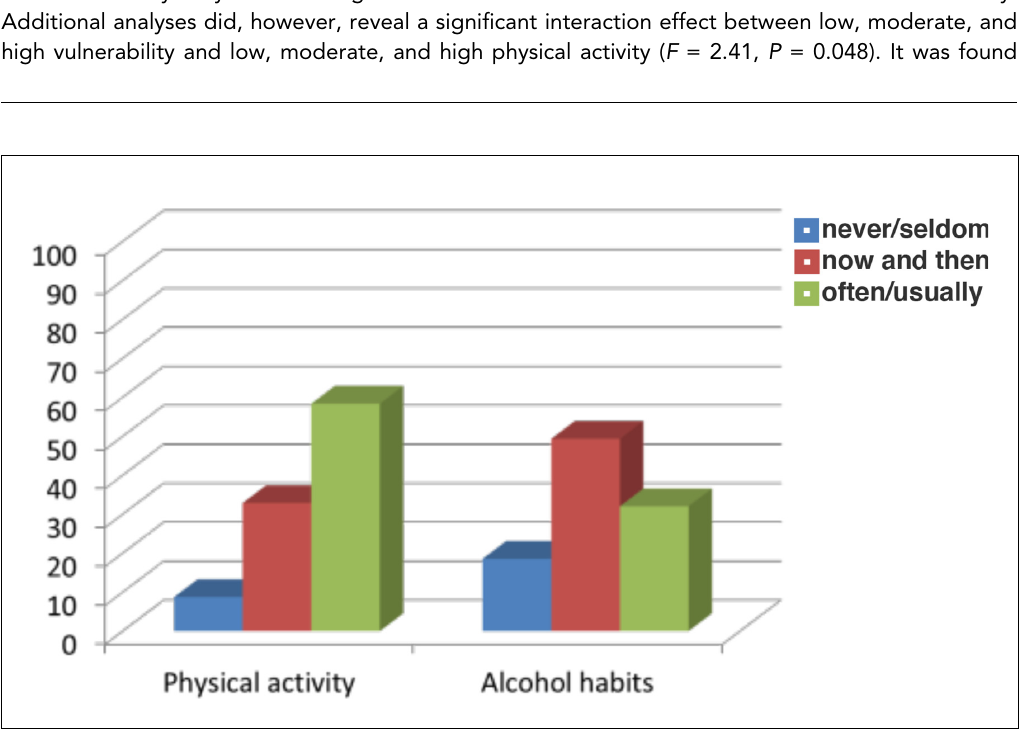
Figure 1. Frequency (%) of counselling about physical activity (N = 526) and alcohol habits (N = 524) in 2014 for all